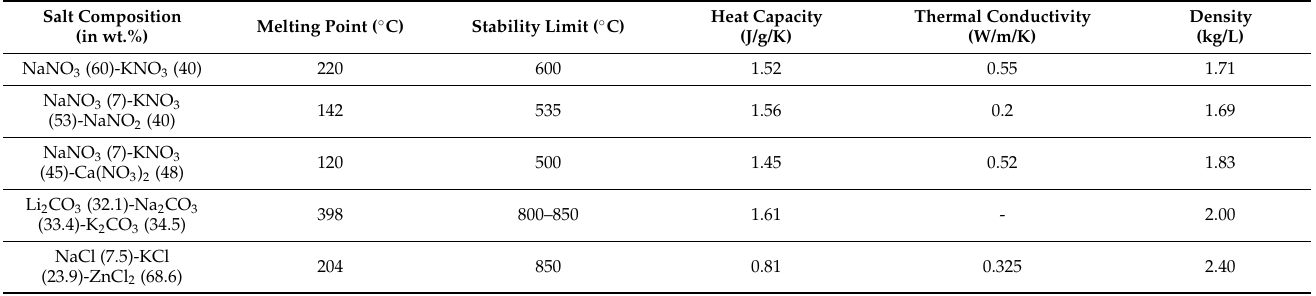
Figure 1. Schematic configuration of concentrated solar power technology. Table 1. Thermal and physical properties of various types of molten salt mixtures proposed for TES systems